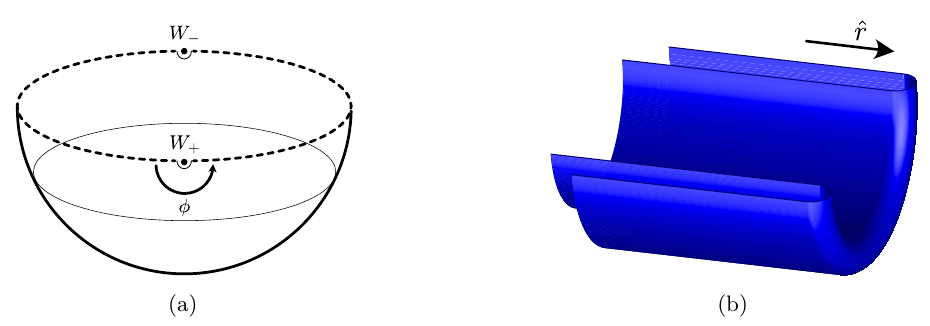
Figure 7 . The TFD State of a Pair of Folded Strings . With insertions of Euclidean time winding operators W + , W − , the worldsheet should be treated in angular quantization to discuss the con- tinuation to Lorentzian target time. One foliates the worldsheet in radial lines, such as the two dashed semi-circles shown on the left, with the angular direction interpreted as Euclidean time. The resulting Hilbert space H + − ( R ) lives on a line, labeled by asymptotic conditions associated to the operator insertions at either end. The functional integral over the halved worldsheet shown prepares the TFD state in two copies of H + − ( R ) . The asymptotic conditions for W ± send ˆ r → −∞ with winding ± 1 . A schematic of the spacetime image of the halved worldsheet is shown on the right. In particular, the two dashed spatial slices map to the folded strings bounding the blue figure, emanating from the strong-coupling